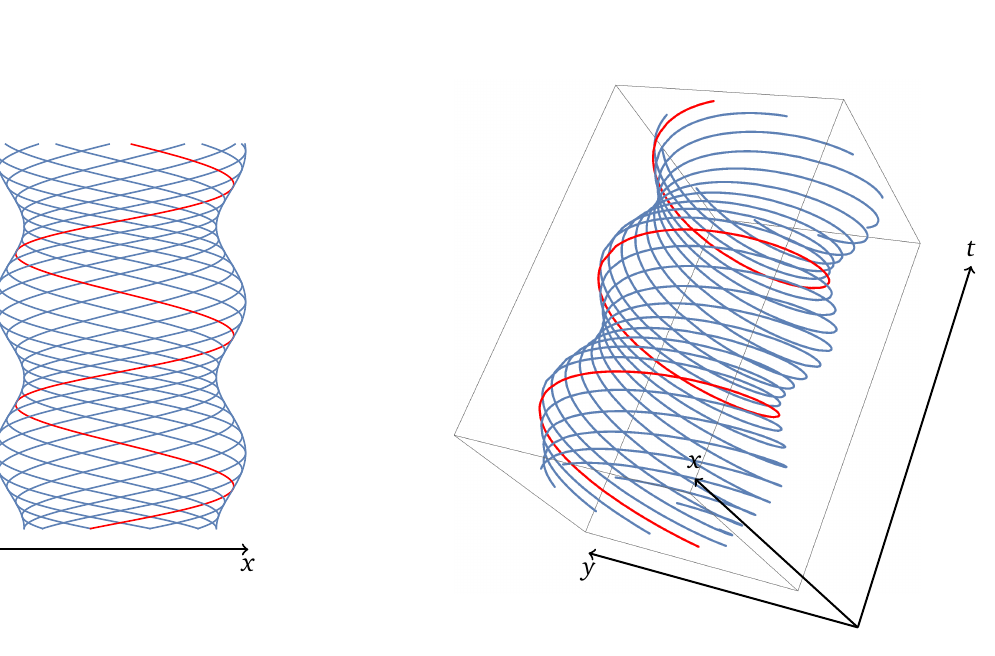
Figure 4: (Left) trajectories x ( t ) of a classical pointlike particle in a har- monic trap with time-dependent frequency (here plotted for the particular choice (cid:113) /ω 2 − 1 ) sin 2 ( ω b ( t ) = t ) corresponding to a sudden quench of the fre- 1 + ( ω 2 1 0 1 → ω quency ω at t = 0). (Right) “Holographic” picture [ 62 ] : the trajectories x ( t ) 0 1 can be viewed as the projection of the 2d motion of a pendulum rotating around the origin in the x − y -plane, thus making the conservation of 2d angular momentum (31)